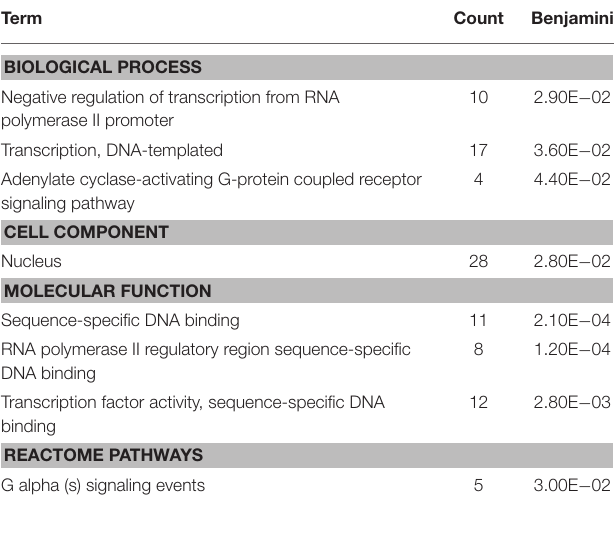
TABLE 3 | Gene Ontology (GO) and Kyoto Encyclopedia of Genes and Genomes (KEGG) pathway enrichment results of differentially methylated genes. Term Count